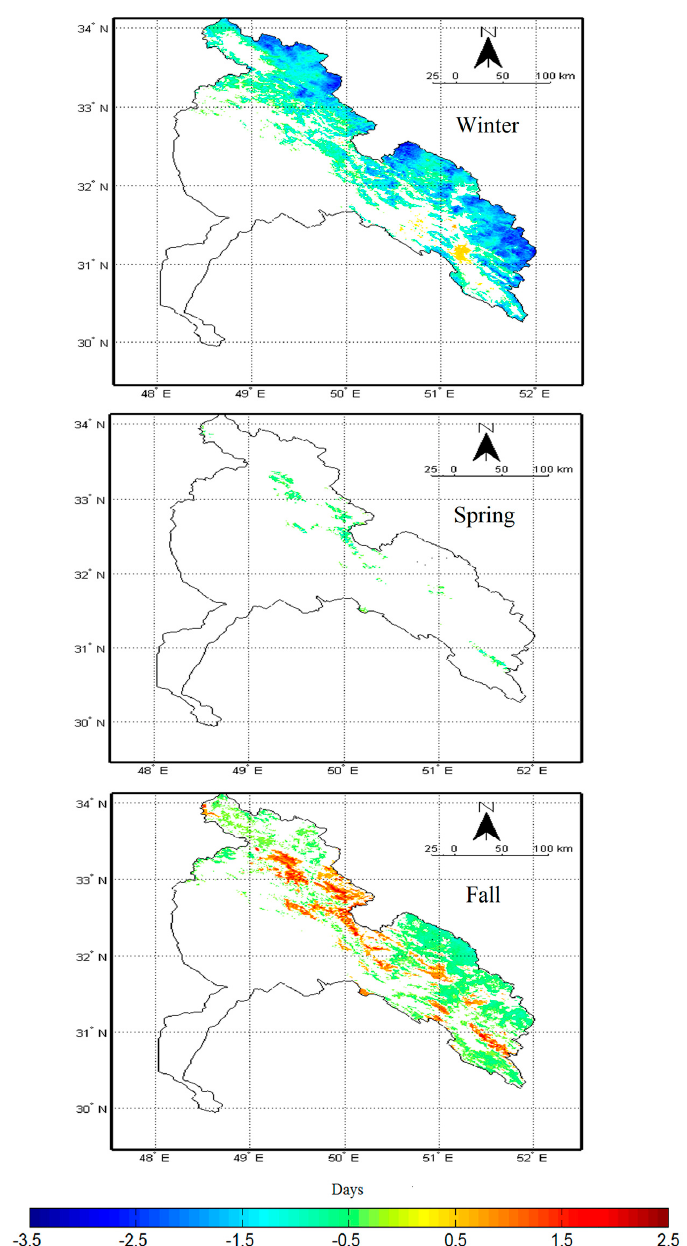
Figure 7. Spatial distribution of trends in SCD (days per year). Only statistically significant trends are displayed, otherwise the area is considered to have no trend (see Table 1).